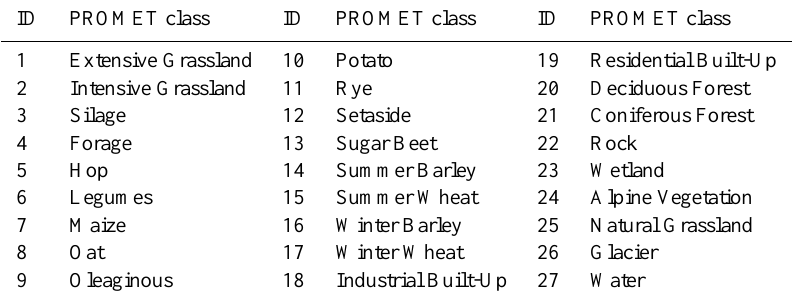
Table 1. PROMET land use/cover classes.